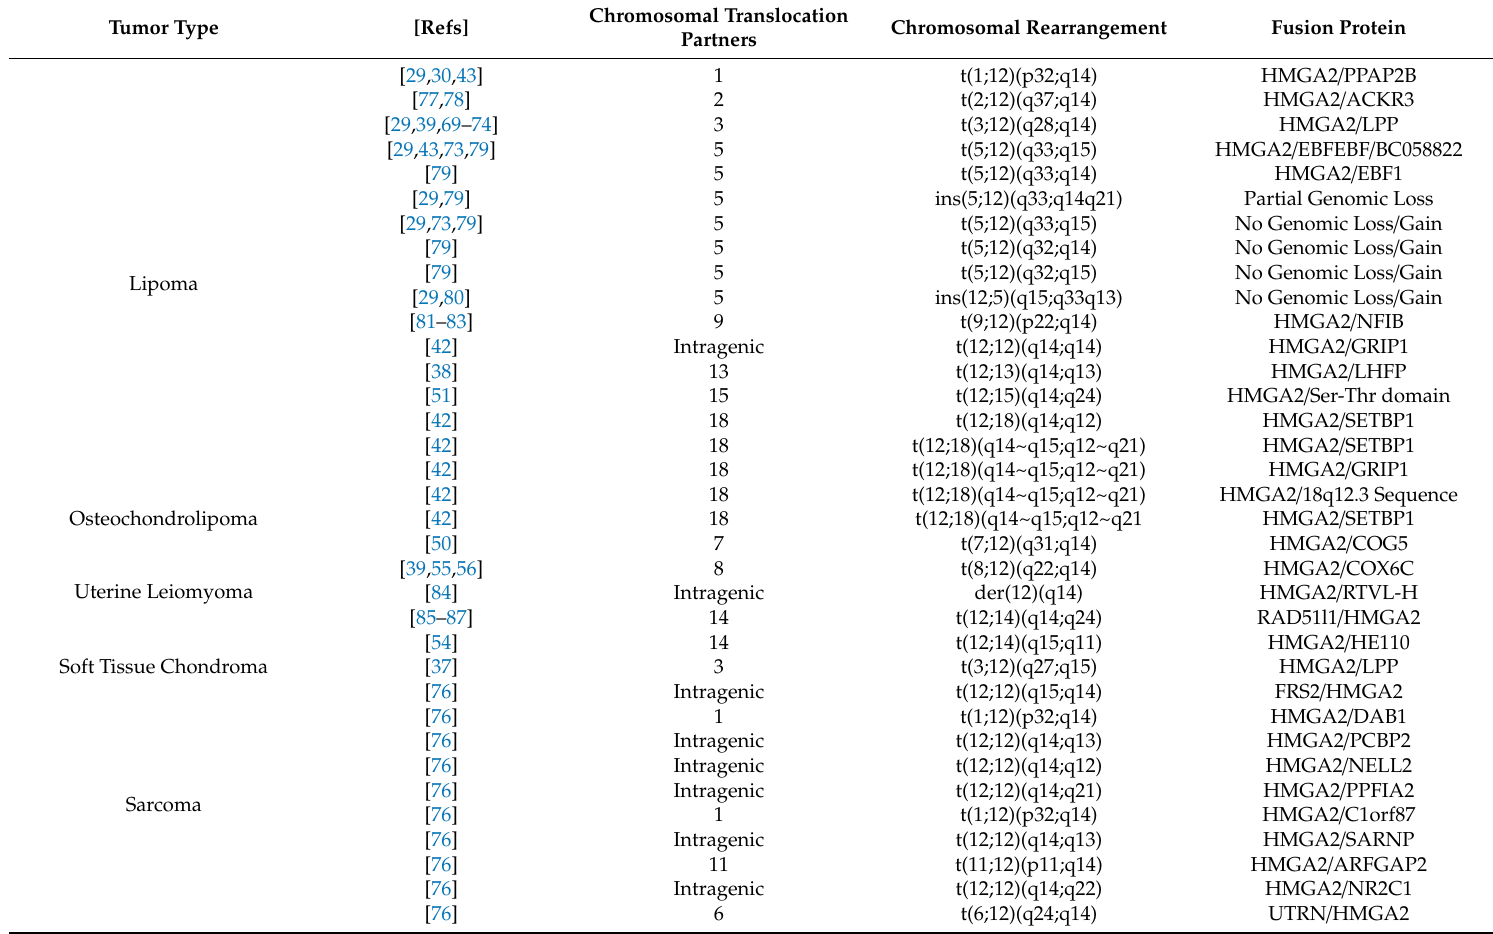
Table 1. Balanced Chromosomal Rearrangements Forming Hmga2-Induced Gene Fusions in Human Mesenchymal Tumors. Tumor